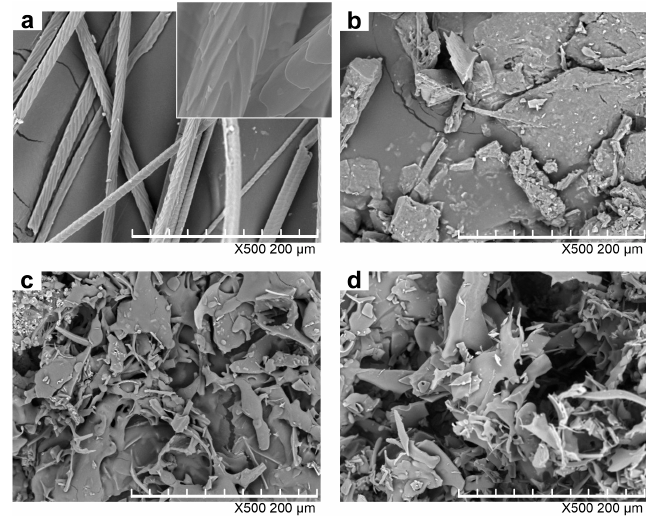
Figure 3. SEM images of rabbit hair ( a ) and keratin samples produced by dissolving at 80 ( b ), 98 ( c ), and 120 °C ( d ).